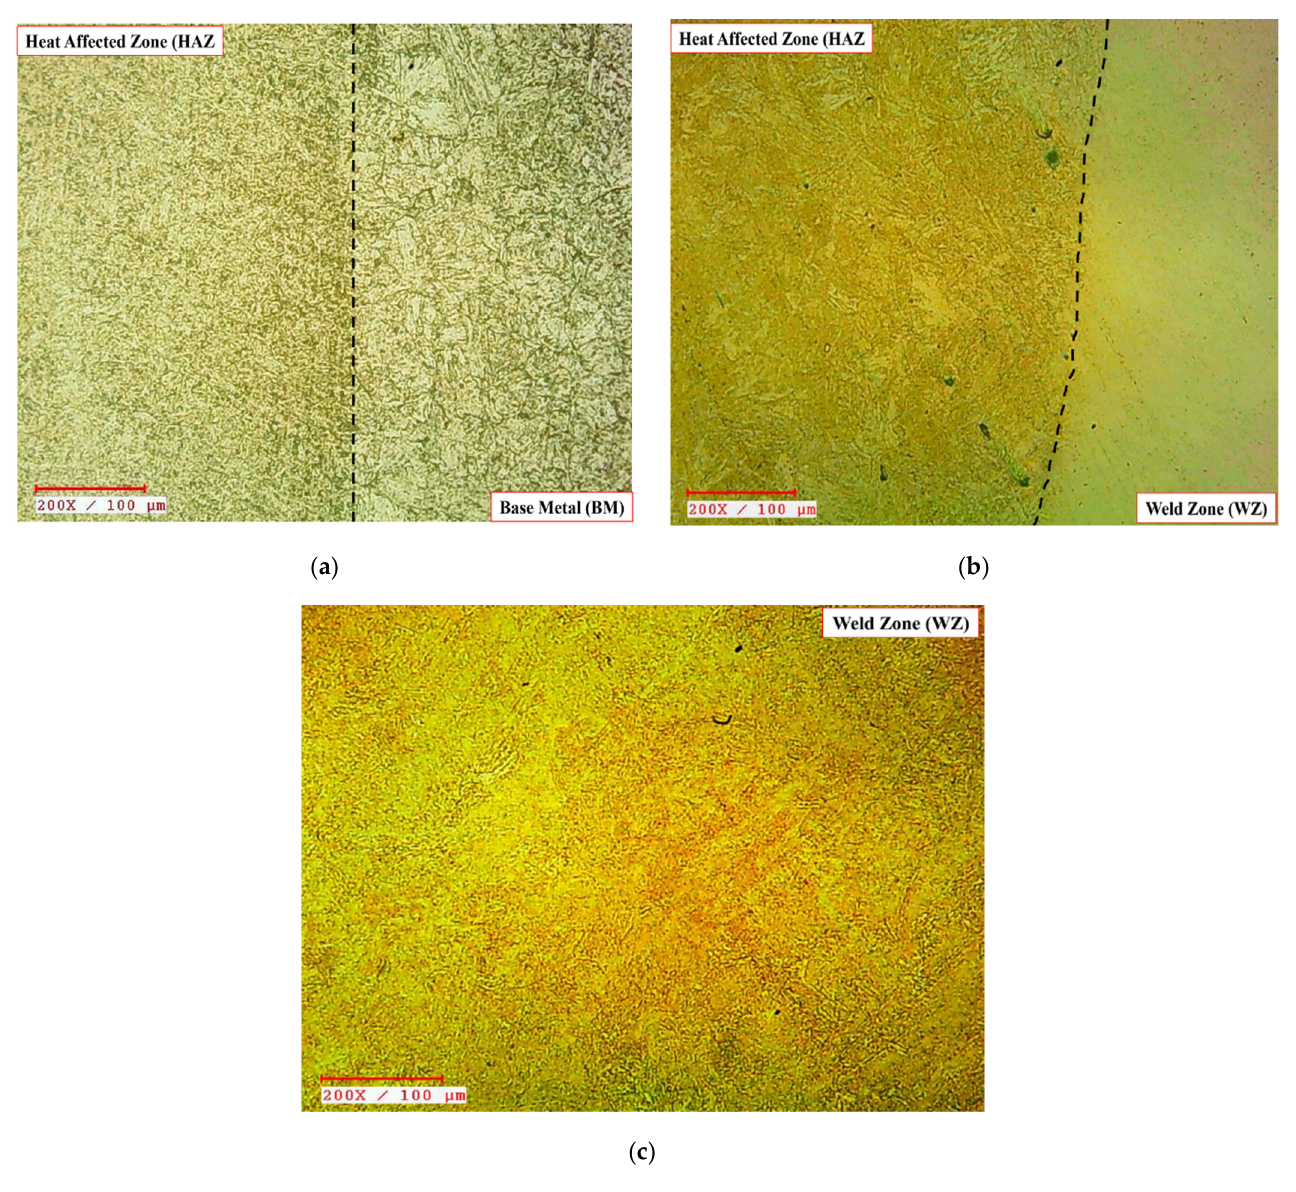
Figure 7. Surface morphology of the ASTM A387-Gr.11-Cl.2 weldments in various regions before heat treatment. ( a ) BM-HAZ interface. ( b ) HAZ-WZ interface. ( c ) WZ.